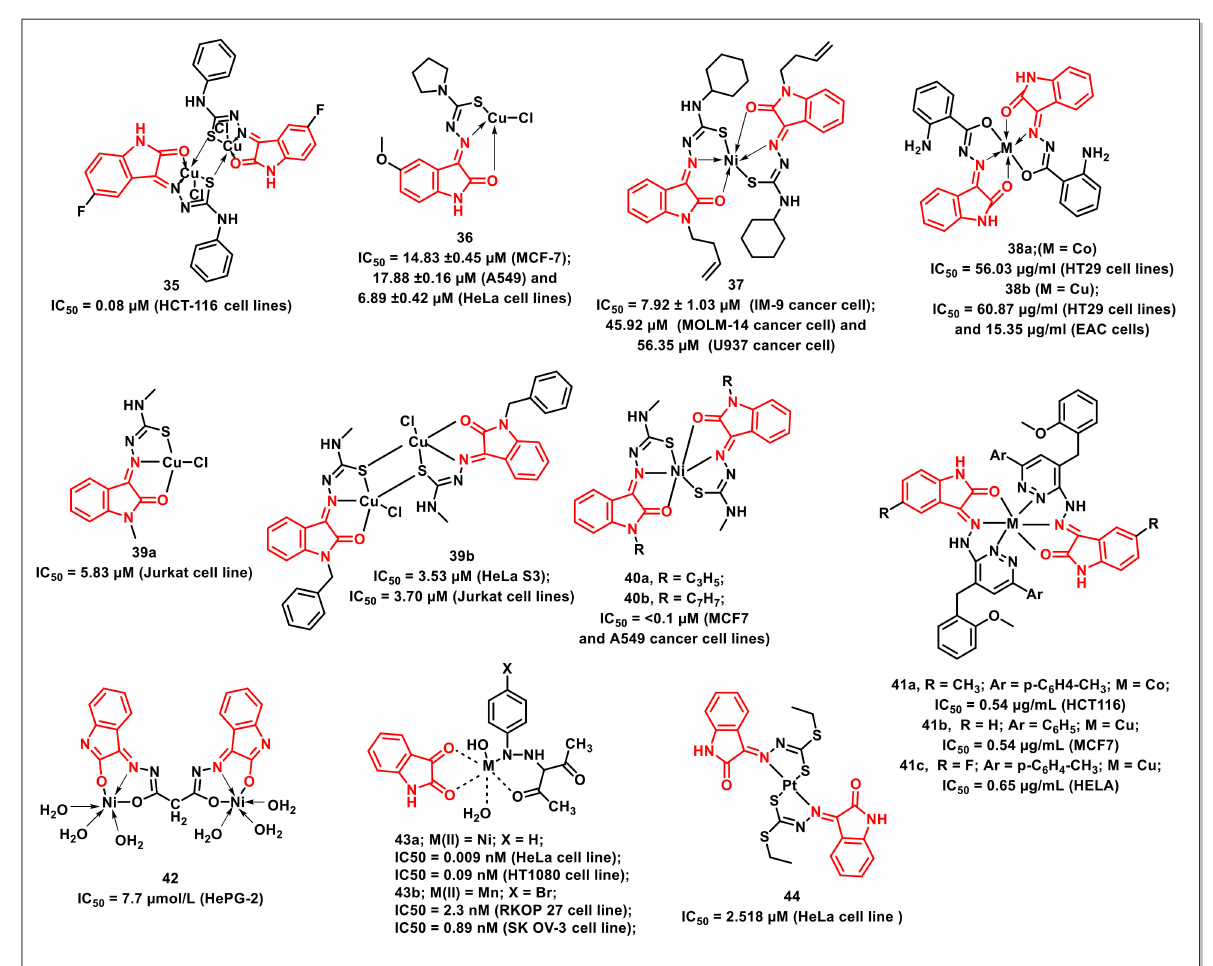
and triggered caspases-3 in IM-9 cells [49].